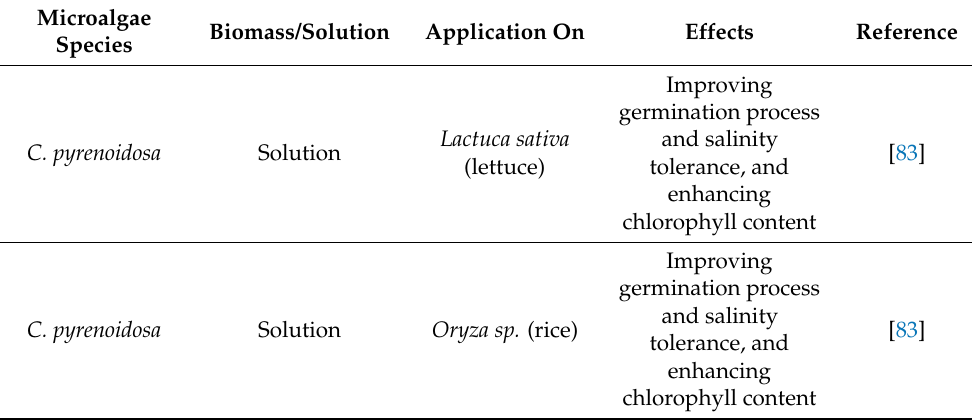
Table 4. Biofertilizer effects of different microalgae